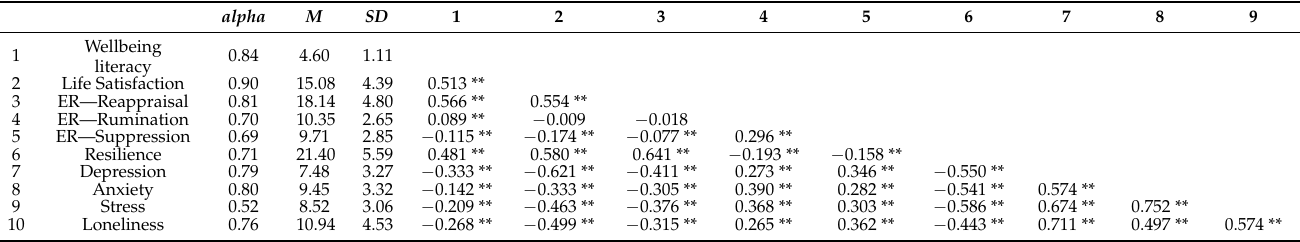
Table 3. Correlations between the study variables in the student sample.